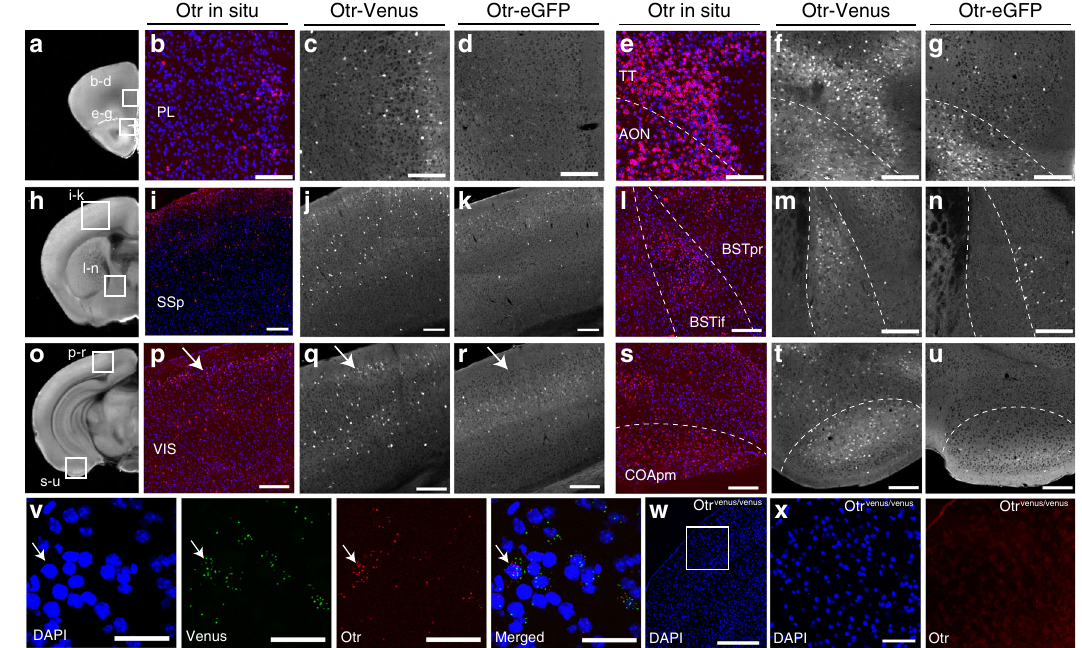
Fig. 1 Characterization of Otr transgenic reporter mice. a – u Comparison between the Otr fl uorescent in situ hybridization and Otr transgenic reporter mouse lines at P21. Scale bar = 200 μ m. The white boxes in the fi rst column represent brain regions in zoomed-in pictures on subsequent columns. The second and the fi fth column for the Otr in situ, the third and the sixth for the Otr-Venus mice, and the fourth and the seventh for the Otr-eGFP mice. b – d the prelimbic cortex (PL), e – g the taenia tecta (TT) and the anterior olfactory nucleus (AON), i – k the primary somatosensory cortex (SSp), l – n the bed nucleus of stria terminalis (BST) interfascicular (if) and principal (pr) nucleus, p – r the visual cortex (VIS), and s – u the cortical amygdala posterior medial (COApm) area. Note the corresponding patterns between the Otr in situ and the OTR-Venus, but not OTR-eGFP. v Double fl uorescent in situ against the Otr and the Venus in the cortex from the Otr-Venus mice. The white arrows indicate an example of both Otr and Venus -positive cells. Scale bar = 50 μ m. w , x Otr in situ hybridization on OTR KO ( OTR venus/venus ) mice. x the somatosensory cortex from the white boxed area in w . Note the lack of Otr puncta. Scale bar = 400 μ m for w and 100 μ m for x .